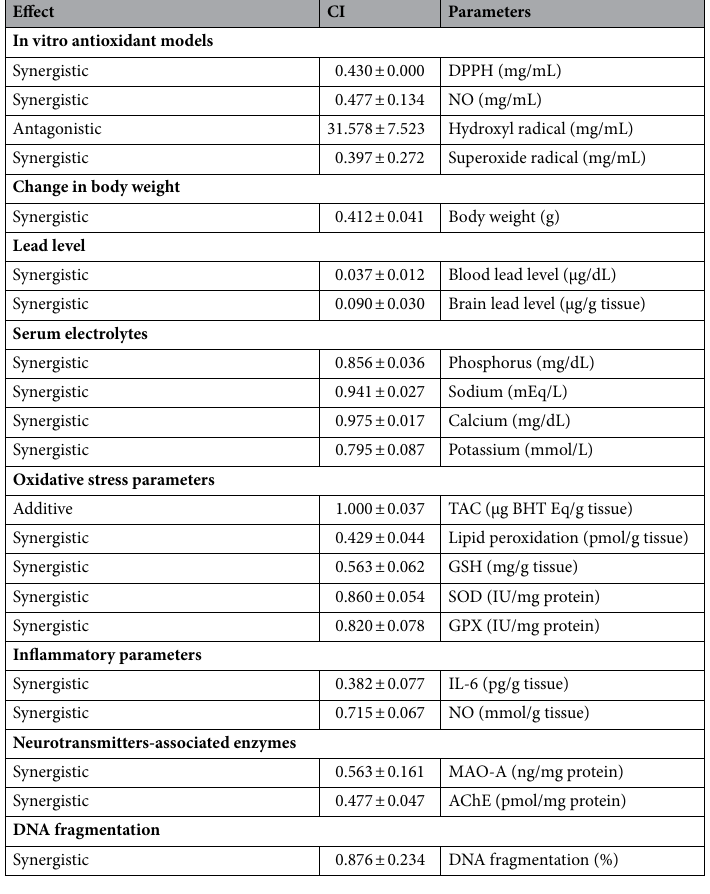
BVJ reduced the OS induced by Pb in rat brain. The injection of Pb into rats dramatically increased the level of lipid peroxidation (Fig. 3I) and decreased the level of GSH and total antioxidant capacity (TAC) (Fig. 3II, III, respectively), and the activity of SOD and GPx (Fig. 3IV, V, respectively). Treatment with BVJ before, during, and after Pb injection showed significant ( p ˂ 0.05) suppression in lipid peroxidation level and substantial elevation as well as normalization of TAC level and GPx activity relative to the Pb group. Also, this treatment increased GSH level (significantly) ( p ˂ 0.05) and SOD activity (non-significantly) as compared to the Pb group. While the administration of DMSA after Pb injection was significantly ( p ˂ 0.05) lowered the lipid peroxidation induced by Pb in brain tissue, but its level was still higher than the control. Additionally, this treatment improved signifi- cantly the TAC and GSH levels and GPx activity and also, SOD activity (non-significantly) as compared to the Pb group where some parameters became near to their controls. Similarly, treatment with BVJ and DMSA together influenced on the antioxidant indices. Regarding the CI value, the combination of BVJ and DMSA had synergistic (CI ˂ 1) action on the OS parameters, except for TAC that showed an additive (CI = 1) effect (Table 3). On the other hand, the healthy rats administered with BVJ alone for 31 days reported no significant changes in the OS indices in the brain tissue. BVJ reduced the inflammation induced by Pb in rat brain. The findings reported that Pb injection did not influ- ence on the NO level of brain tissue (Fig. 4I). Likewise, treatment with either, (BVJ and DMSA together) or DMSA after Pb injection showed no significant changes in the brain NO level. Also, administration of healthy rats with BVJ after Pb injection appeared no significant change in the brain NO level. Otherwise, the interleukin (IL)-6 level was significantly (p ˂ 0.05) elevated in rat brain tissues which injected with Pb (Fig. 4II). Treatment with BVJ, (BVJ and DMSA together), or DMSA after Pb injection dramatically inhibited the elevation in IL-6 comparable to the Pb group, but the level stilled higher than the control. The CI analysis demonstrated the synergistic (CI ˂ 1) effects of the combination between BVJ and DMSA on depleting